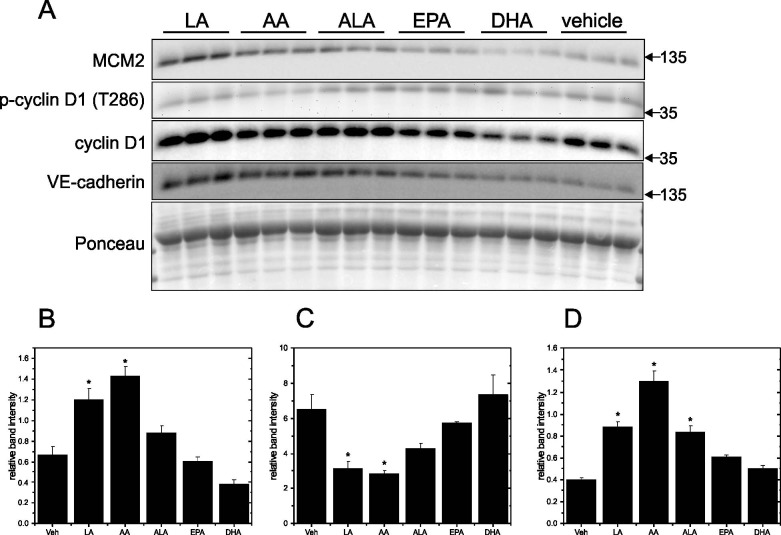
Effect of PUFA treatment on MCM2, p-cyclin D1, cyclin D1 and VE-cadherin in subconfluent EA.hy926 cells grown on Matrigel-coated plates.EA.hy926 endothelial cells were seeded on Matrigel-coated plates at 9000 cells/cm2 and grown for 4 days. Cells were treated with PUFAs (LA, AA, ALA, EPA and DHA) individually at 125 μM for 8 h. Protein levels of MCM2, p-cyclinD1, cyclin D1 and VE-cadherin were determined by Western blotting of cell lysates prepared after treatments. Representative blots are shown in Panel A. Densitometry was used to quantify the intensity of the bands in the upper panel and data were normalized to a band visualized by Ponceau staining. Data are presented as means ± SEM (n = 3) for MCM2 (Panel B), p-cyclin D1/cyclin D1 (Panel C) and VE-cadherin (Panel D). *Significantly different (p <0.05) from vehicle control.